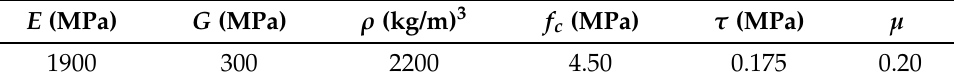
Table 1. Pavia Building 1: Material parameters assumed for masonry elements